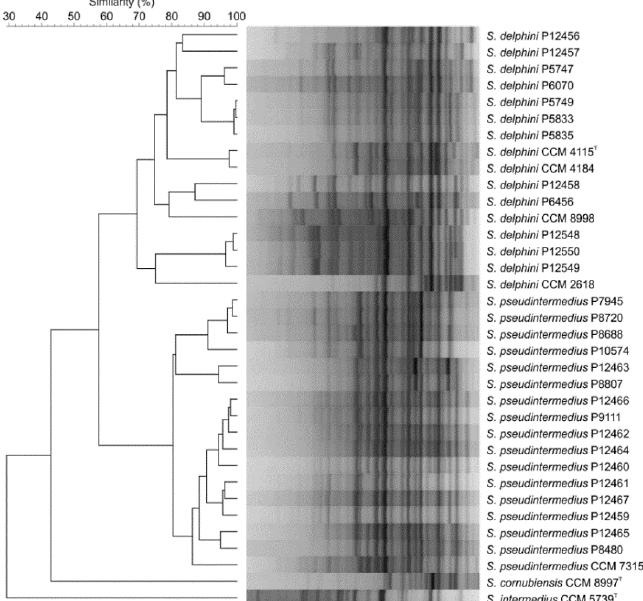
Figure 3. Dendrogram based on cluster analysis of repetitive sequence-based PCR (rep-PCR) fingerprints obtained with (GTG) 5 primer from analyzed isolates and type and reference strains of Staphylococcus intermedius group. The dendrogram was calculated with Pearson's correlation coefficients with unweighted pair group method with arithmetic average (UPGMA) clustering method ( r , expressed as percentage similarity values).